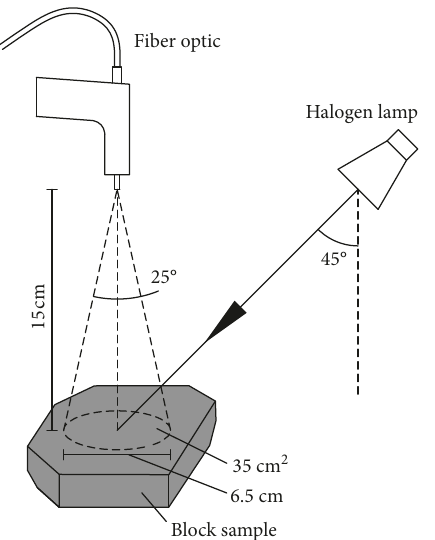
Figure 3: Reflectance spectra acquisition of the top solid surface of each block sample using a field spectrometer and a halogen lamp light